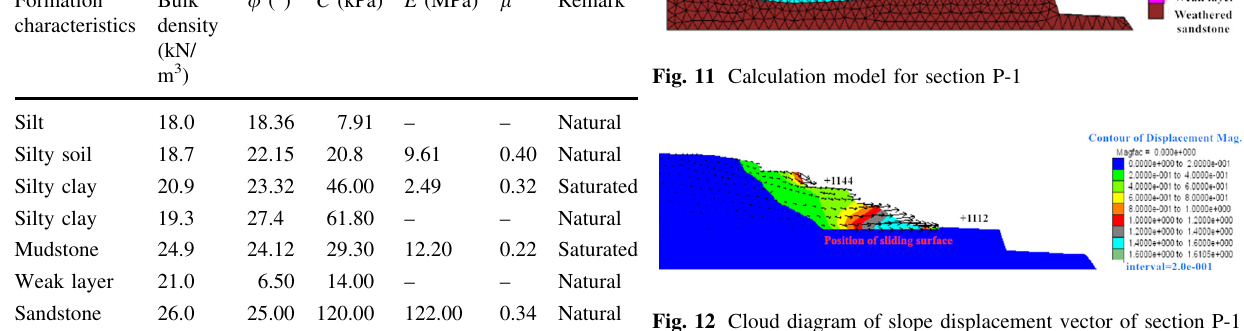
Table 2 Recommended values of physical and mechanical parameters of rock mass Formation Bulk characteristics